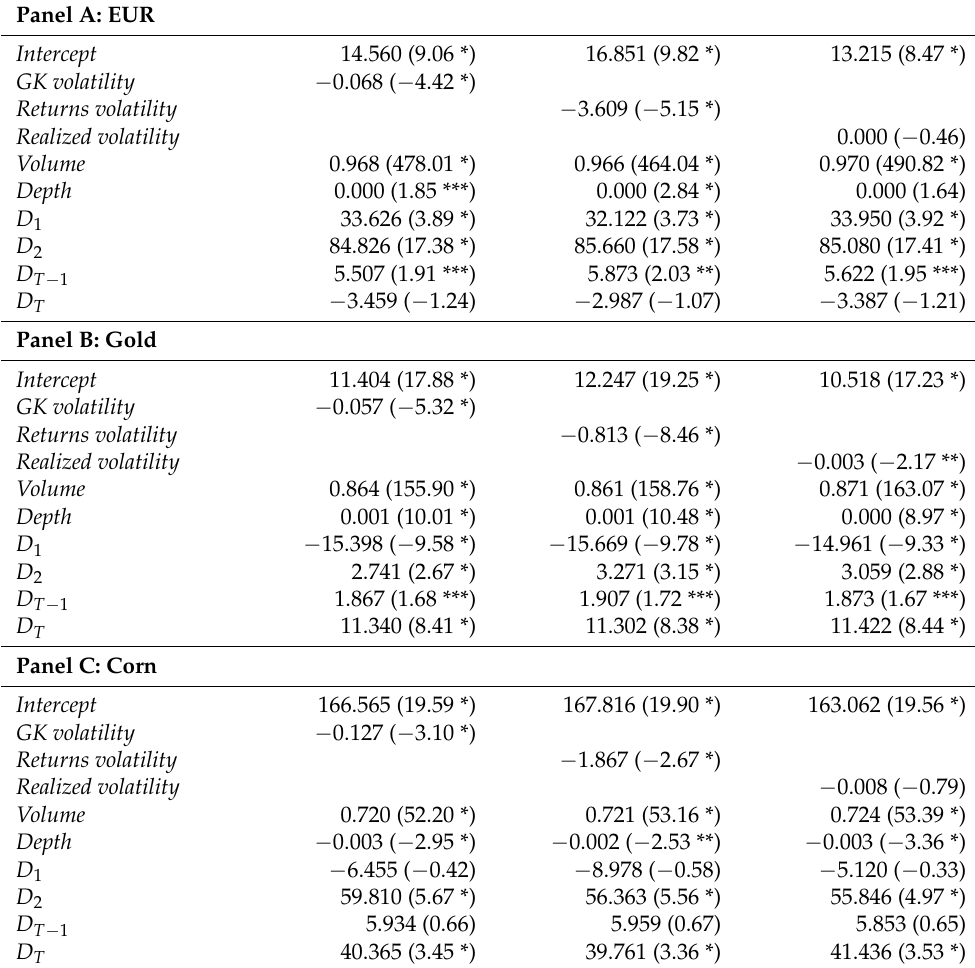
Table 4. Volatility and depth quantity with controls. This table shows the coefficient estimates for